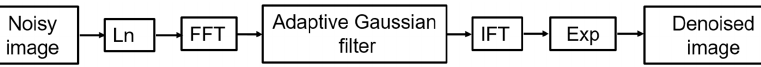
Figure 3. The image representation of the homomorphic filter for five different H r values for two dipole sources at 3 GHz. ( a ) Against five different c values, ( b ) against five different L r values, and ( c) against five different D 0 values.